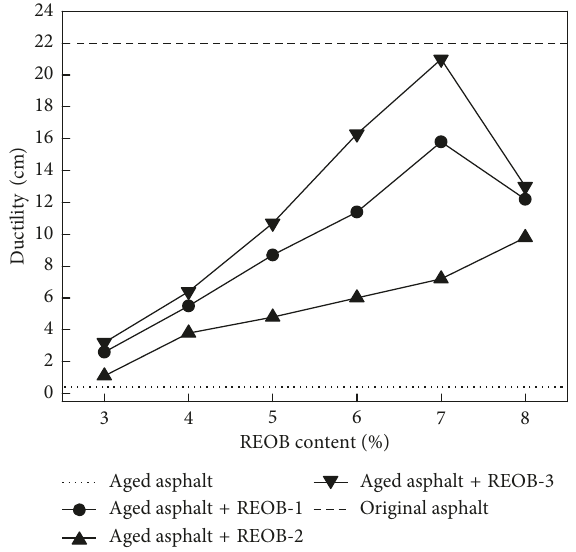
Figure 3: Influence of three types of REOB on ductility of aged